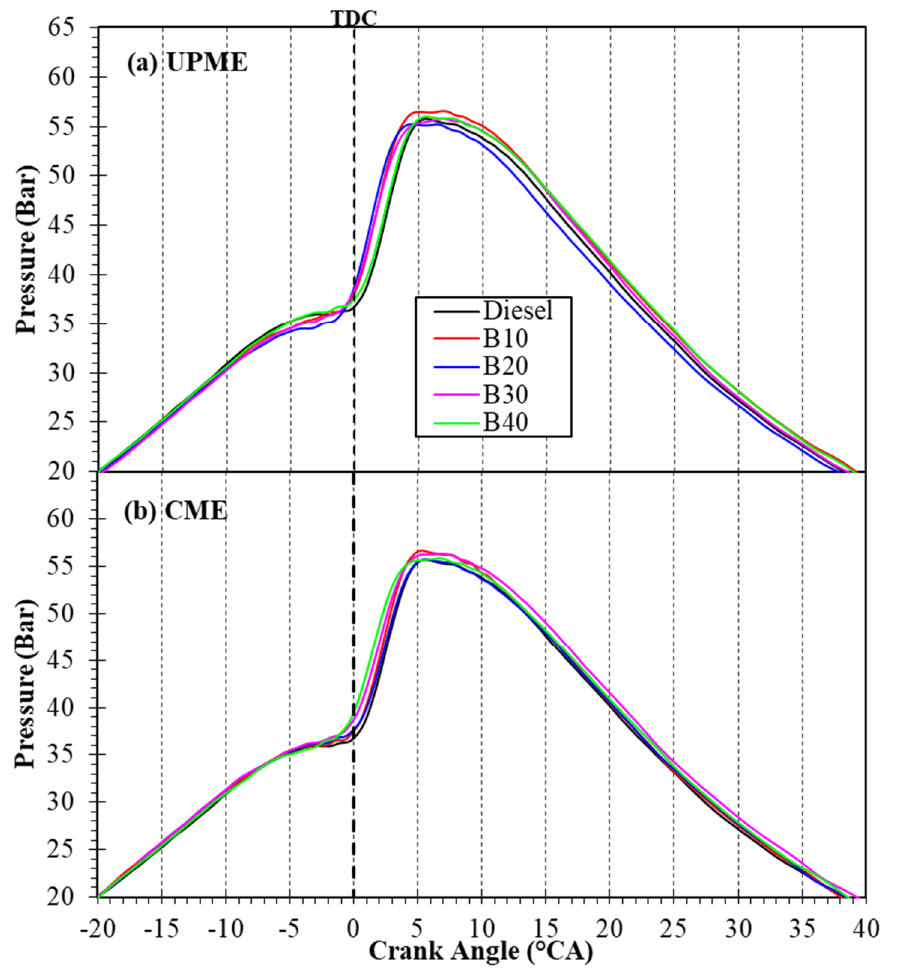
Figure 3. In-cylinder pressure versus crank angle for ( a ) UPME and ( b ) CME fuel blends as compared to standard diesel.